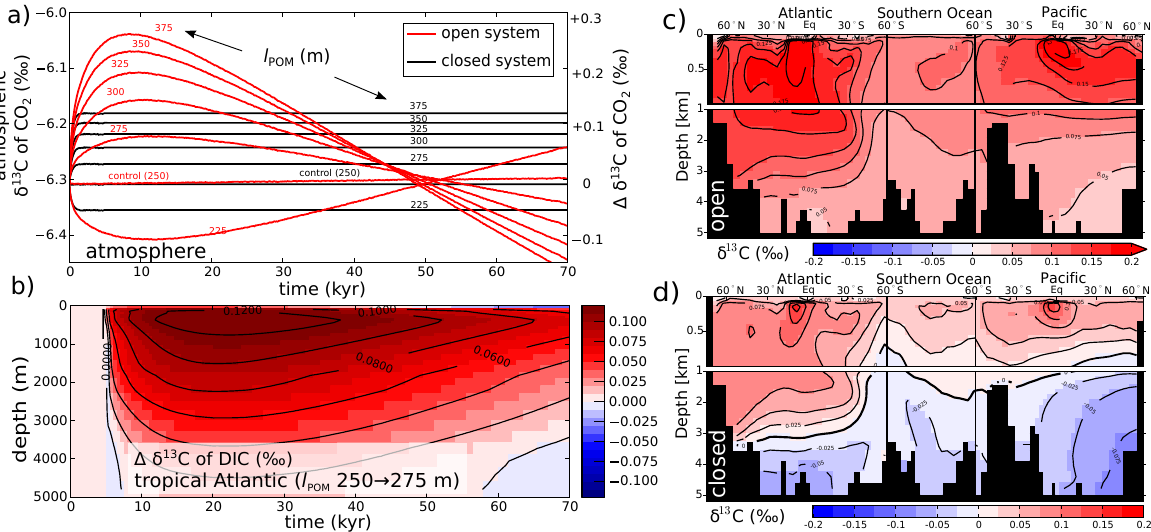
Figure 7. (a) Time evolution of the stable isotope 13 CO 2 mixing ratio, expressed as δ 13 C of CO 2 , for a set of different POM remineralisation depths. The black line shows the response in the closed system, while the red lines show the evolution in the open system. (b) Hovmöller diagram of the change in δ 13 C of DIC averaged over the tropical Atlantic. (c, d) Anomaly in δ 13 C of DIC in the POM deepening experiment after 15kyr in the open and closed systems in a transect through the Atlantic, Southern and Pacific